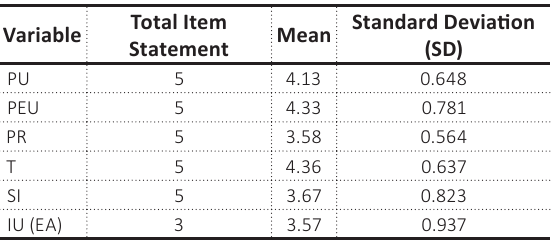
Table 3. Descriptive statistics